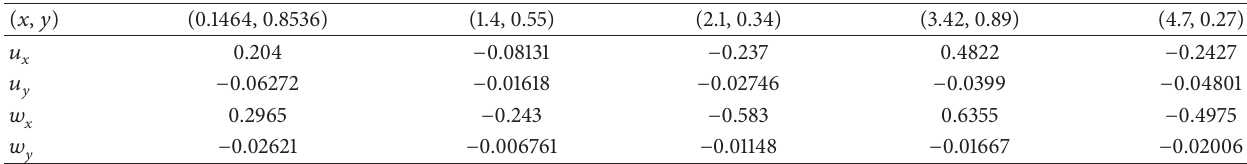
Table 1: The computed